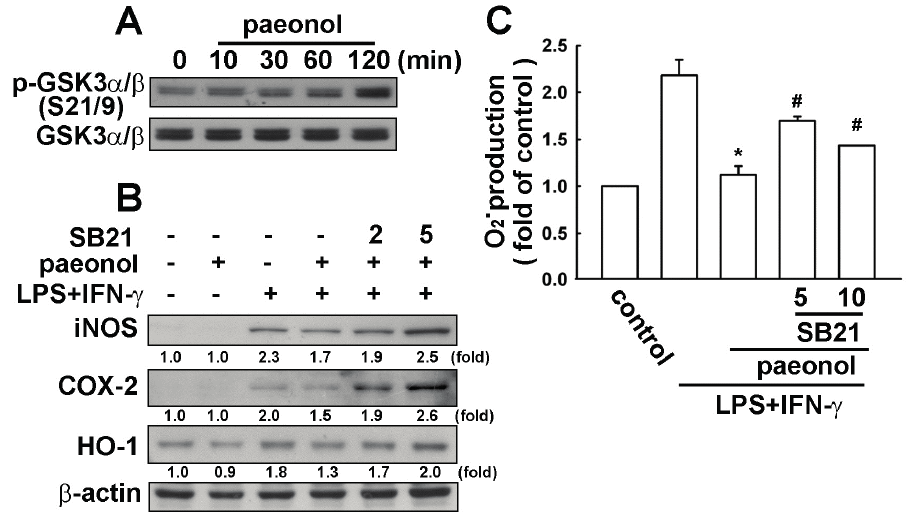
Figure 4. Involvement of GSK3 α / β by paeonol in neuroinflammation. ( A ) BV-2